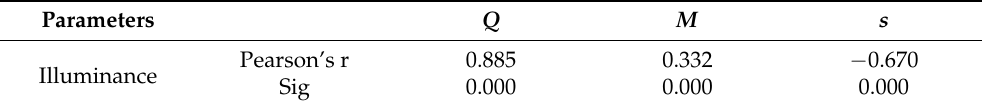
Table 5. Pearson correlation analysis between illuminance and serpentinite colour appearance